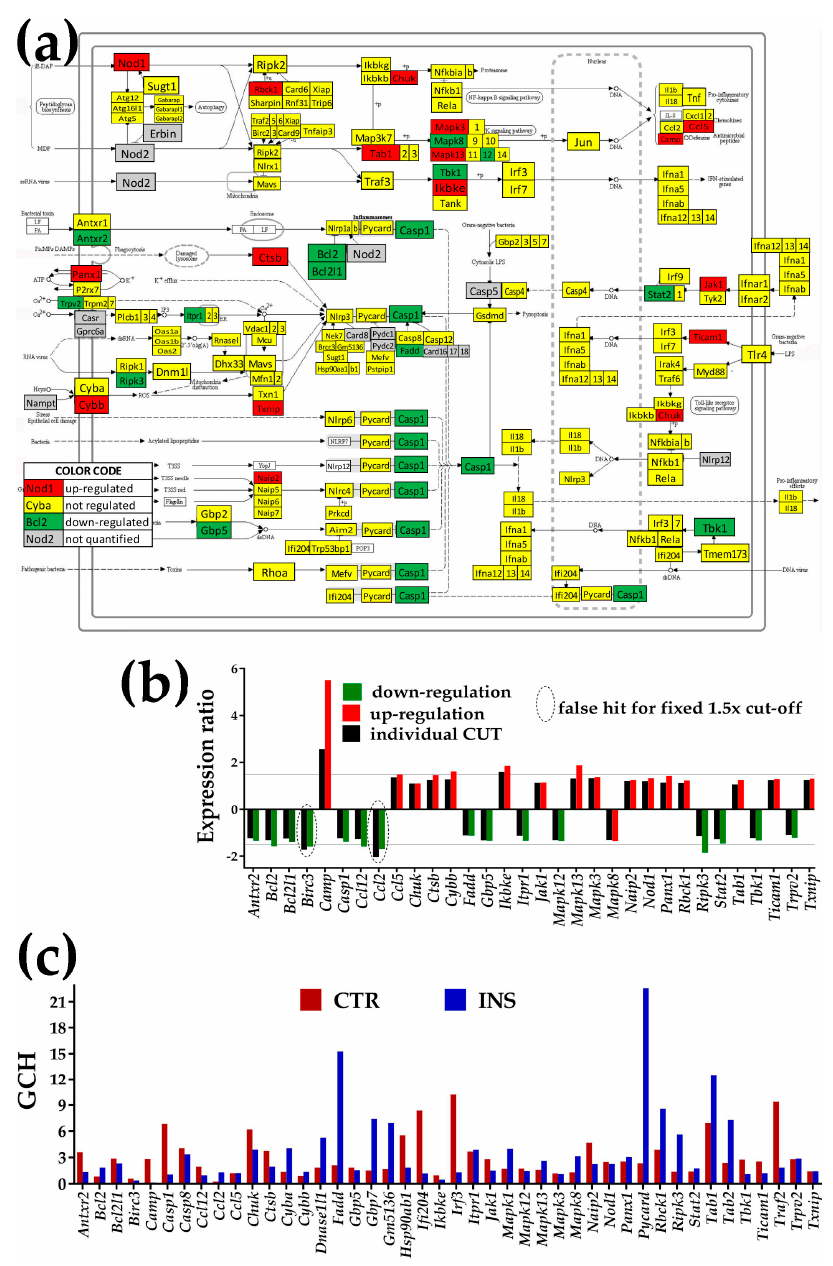
Figure 5. Proximity of non-touching Oli-neu cells affects the NOD-like receptor signaling pathway (modified from http://www.kegg.jp/pathway/mmu04621). (a) Regulation of interconnected genes. (b) Expression ratios and individual fold-change cut-offs (negative for down-regulation) of the significantly regulated genes. Note that Birc3 (baculoviral IAP repeat-containing 3) and Ccl12 (chemokine (C-C motif) ligand 2) would be false hits if the traditional 1.5x were used instead of our individual gene cut-off because although their expression ratios were over the 1.5x limit, they did not exceed their individual CUT. (c) Gene Commanding Height (GCH) scores of selected NOD genes. The set of the significantly regulated NOD genes was completed with genes having GCH over 4 in either condition: Casp8, Cyba, Dnase1l1, Gbp7, Gm5136, heat shock protein ( Hsp90aa1 ), interferon regulatory factor ( Irf3 ), mitogen-activated protein kinase ( Mapk1 ), PYD and CARD domain containing ( Pycard , the most prominent of the NOD pathway in the INS astrocytes), Tab2, Traf2 .